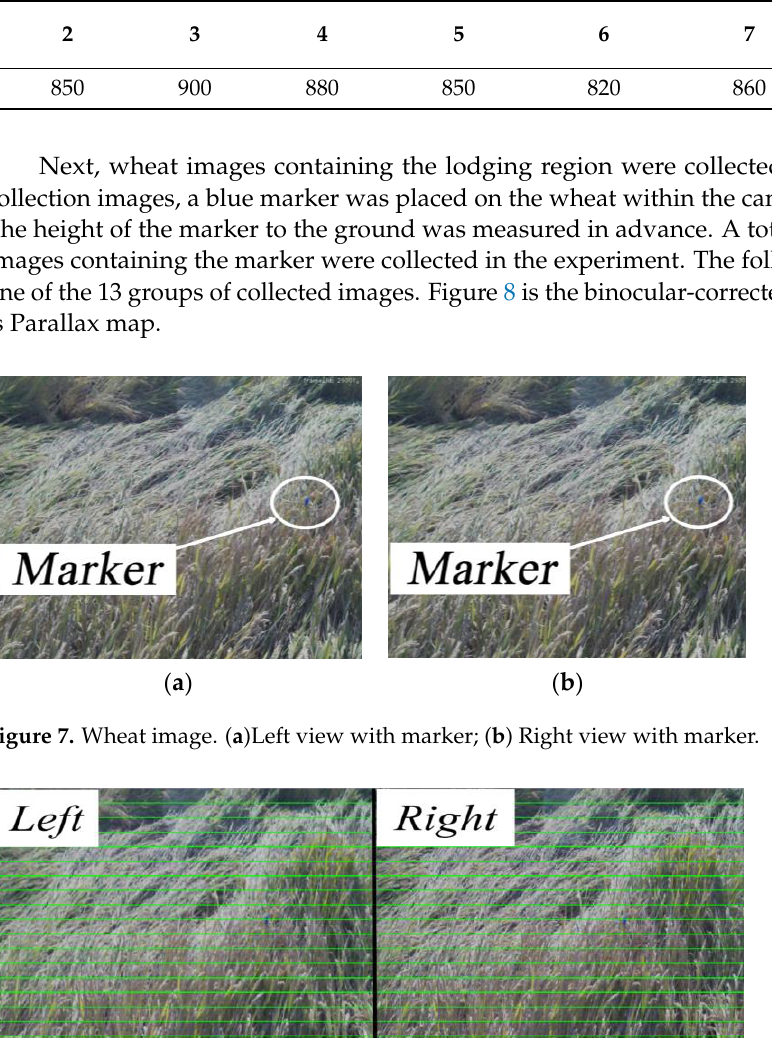
Table 3. Manual measured value of wheat height.